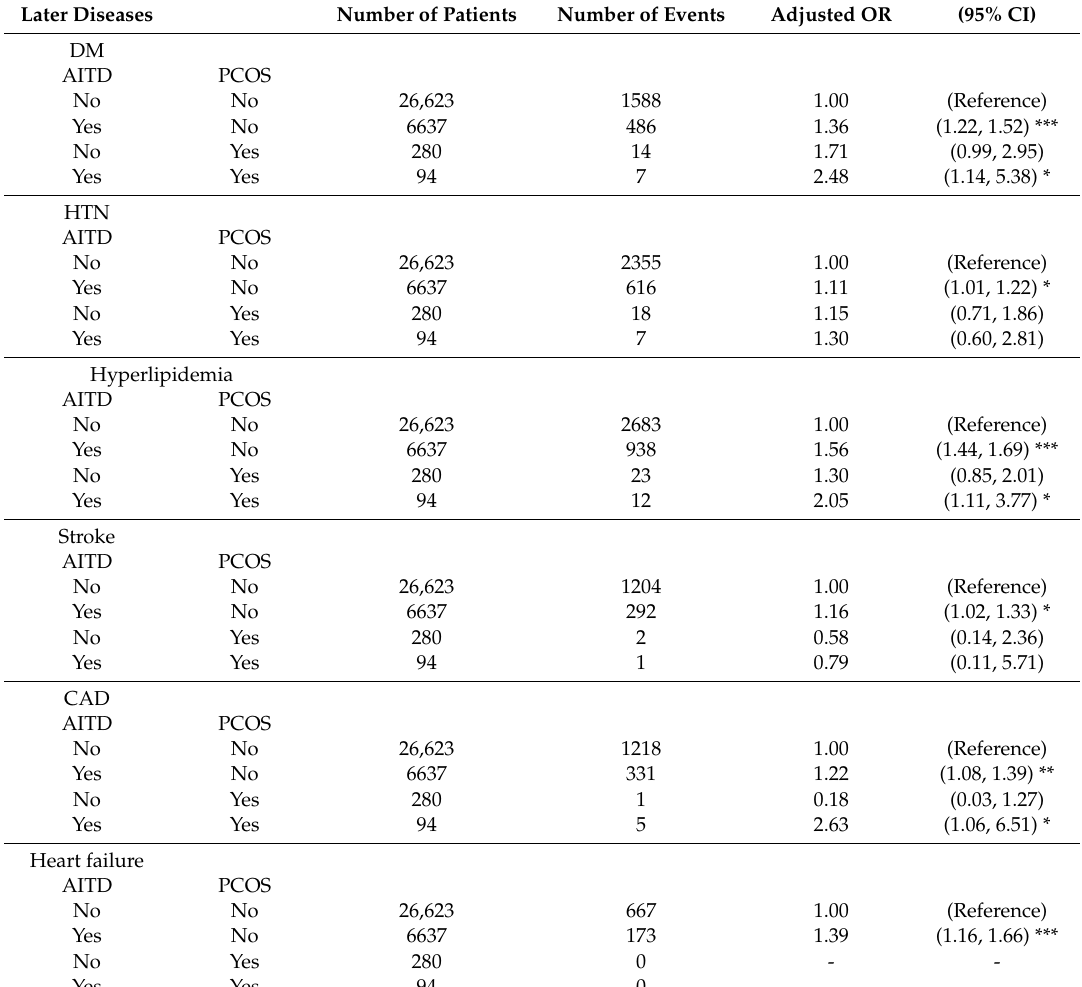
Table 3. The distribution of later diseases in the patients with and without AITD and PCOS. Later Diseases Number of Patients Number of